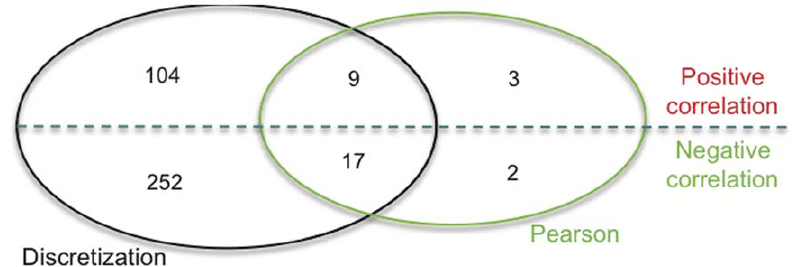
Figure 4. Comparison of Pearson and discretization approaches used to identify methylation-expression correlations. The Venn Diagram displays the total number of overlapping loci with positive/negative methylation-expression correlations identified by computing either a Pearson correlation or applying the discretization method.